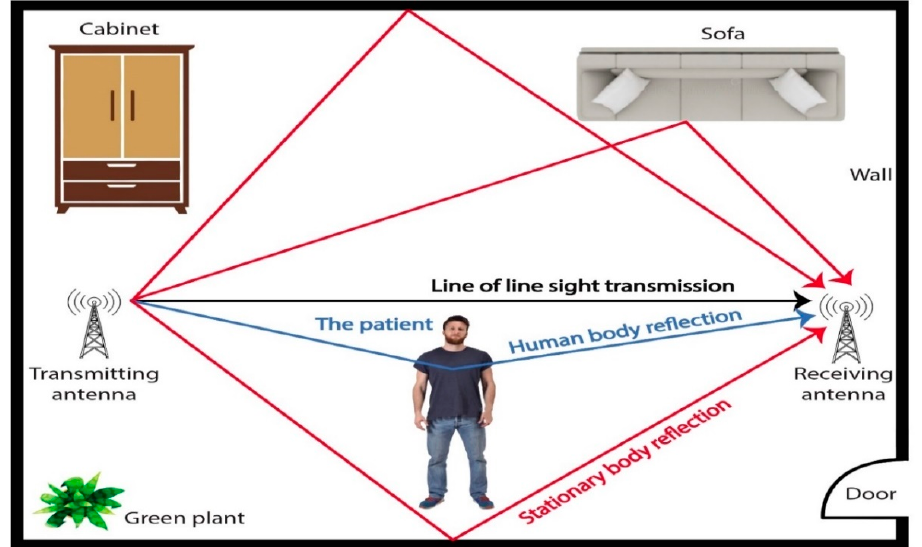
Figure 2. Wireless channel environment for monitoring health.